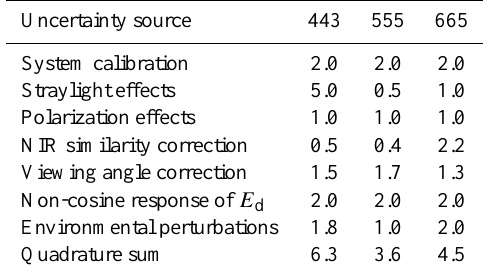
Table 7. Uncertainty budget (in percent) for R rs determined from TRIOS-B data.